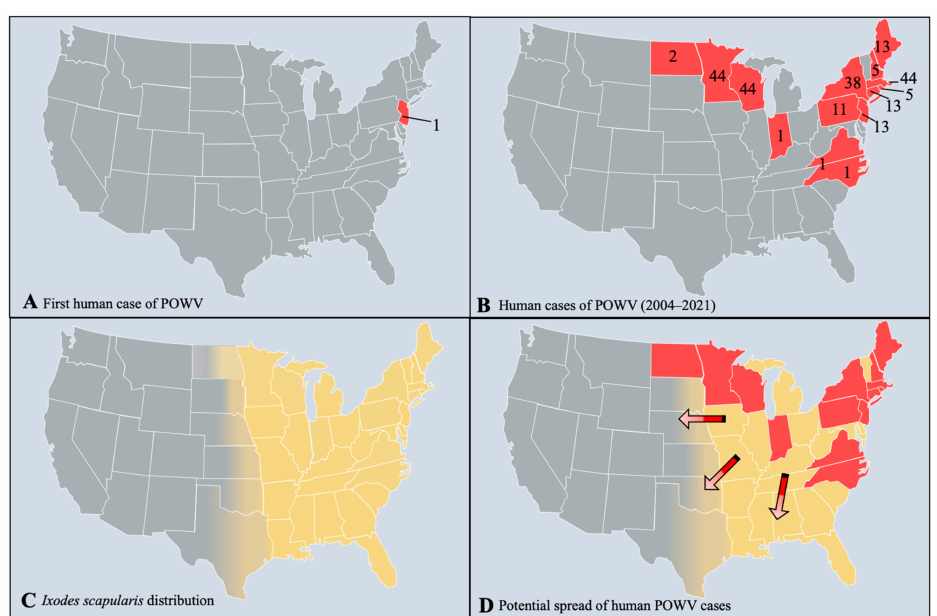
Figure 1. Timeline of major POWV milestones.